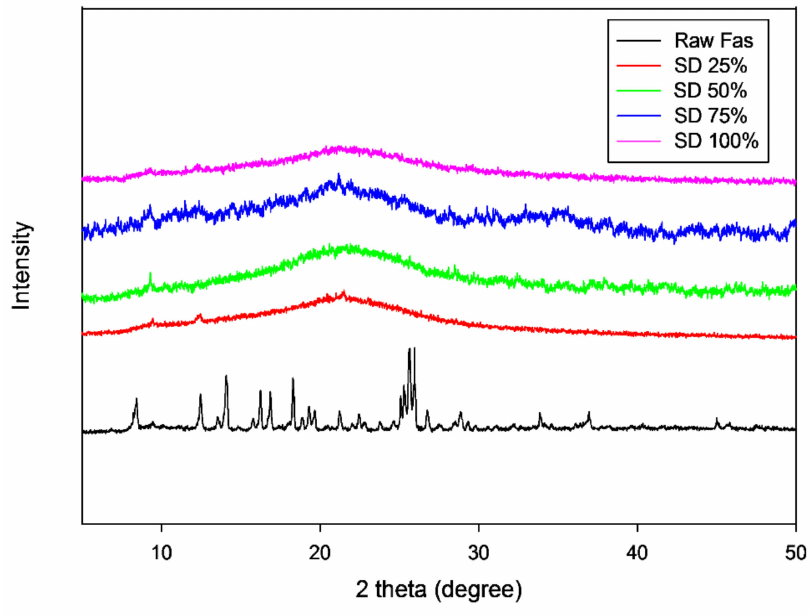
Figure 4. XRPD patterns of raw FAS and SD FAS powders at different spray drying pump rates.